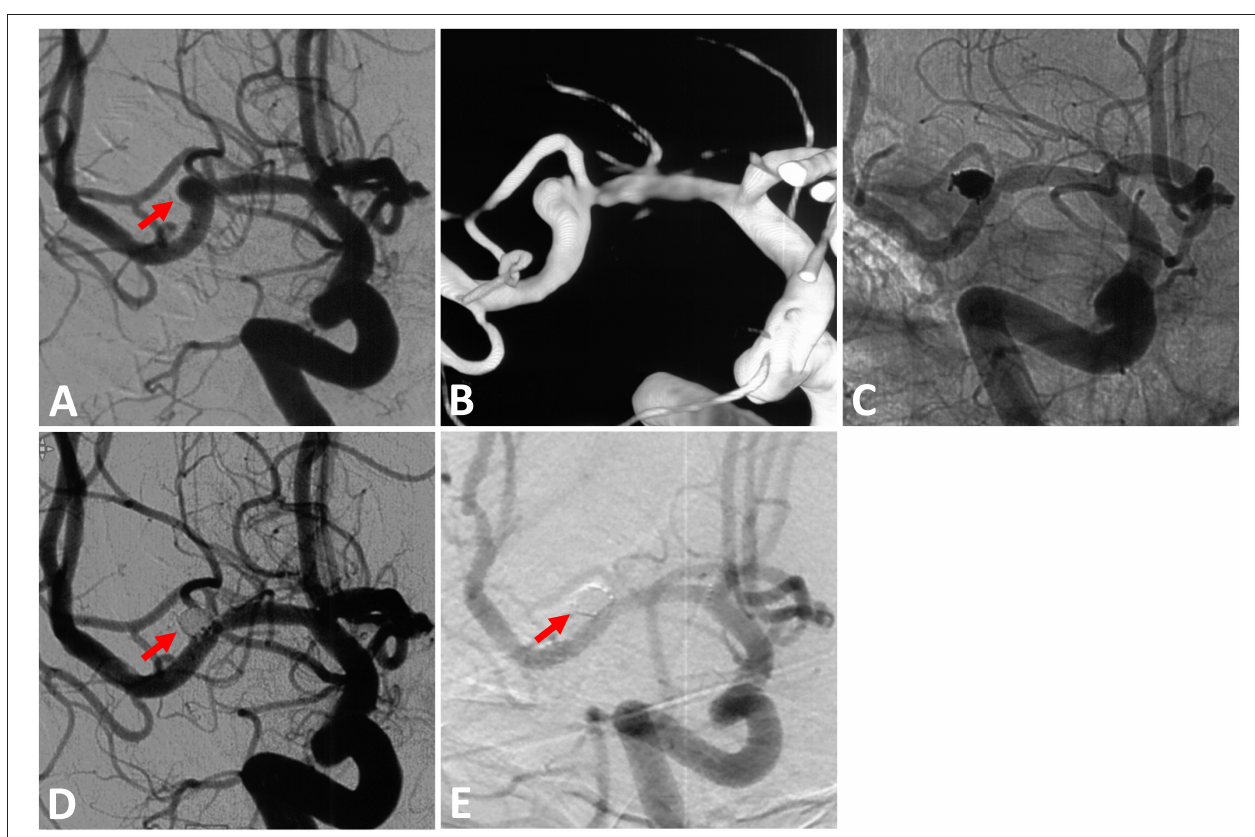
FIGURE 2 | Illustrative case. (A) A 54-year-old woman with a 3.6 × 2.4mm ruptured right middle cerebral artery (MCA) bifurcation aneurysm (solid arrow). (B) Three-dimensional reconstruction of the aneurysm. (C) The LVIS stent (3.5mm × 15mm) was successfully delivered in place. (D) Complete occlusion was achieved under the final view (solid arrow). (E) Digital subtraction angiography performed 16 months later showed complete aneurysm occlusion (solid